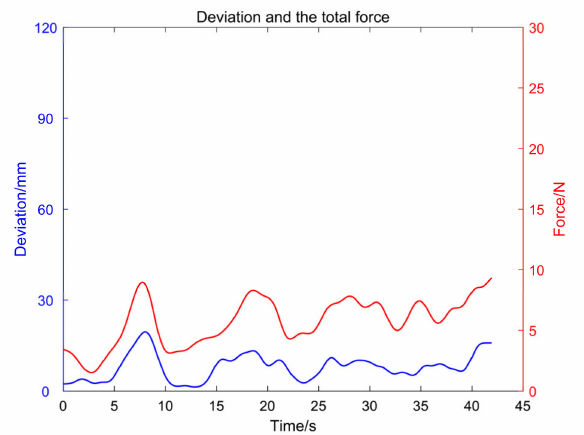
Figure 22. The total interaction force and the deviation between the handle and the subject’s